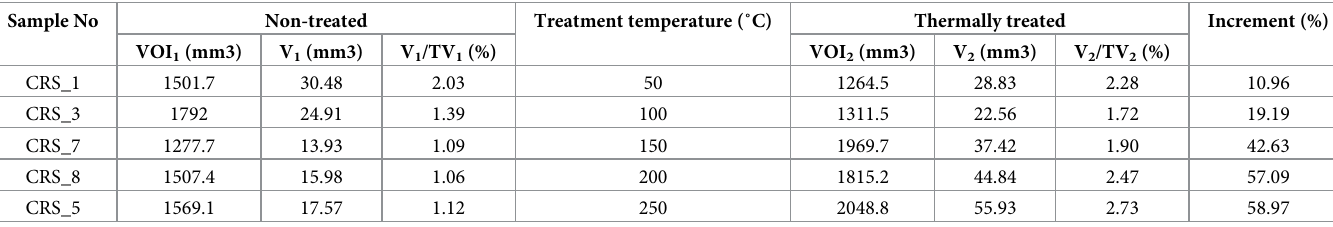
Table 3. Porosity parameters of rock salt calculated from X-ray micro-CT